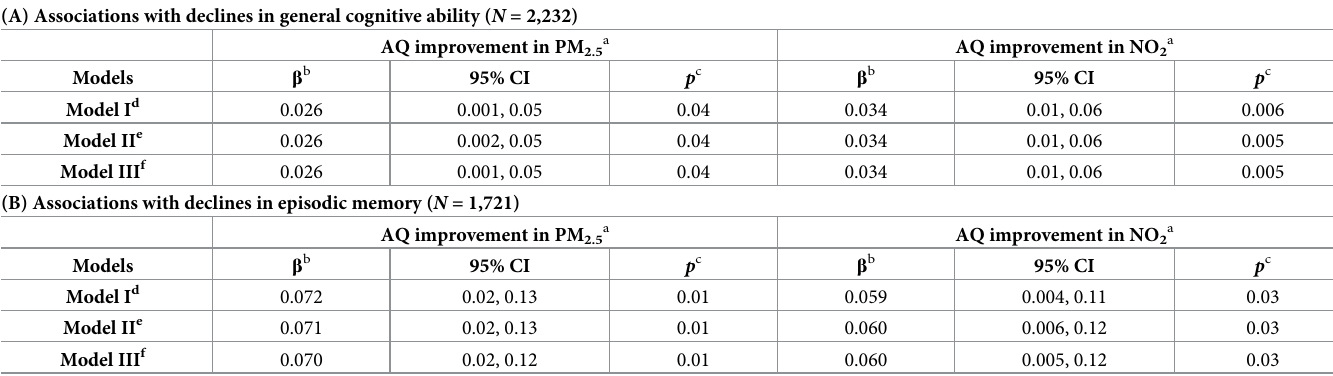
Table 3. Summary of the associations between AQ improvement and cognitive declines in the WHIMS-ECHO cohort. (A) Associations with declines in general cognitive ability ( N = 2,232)